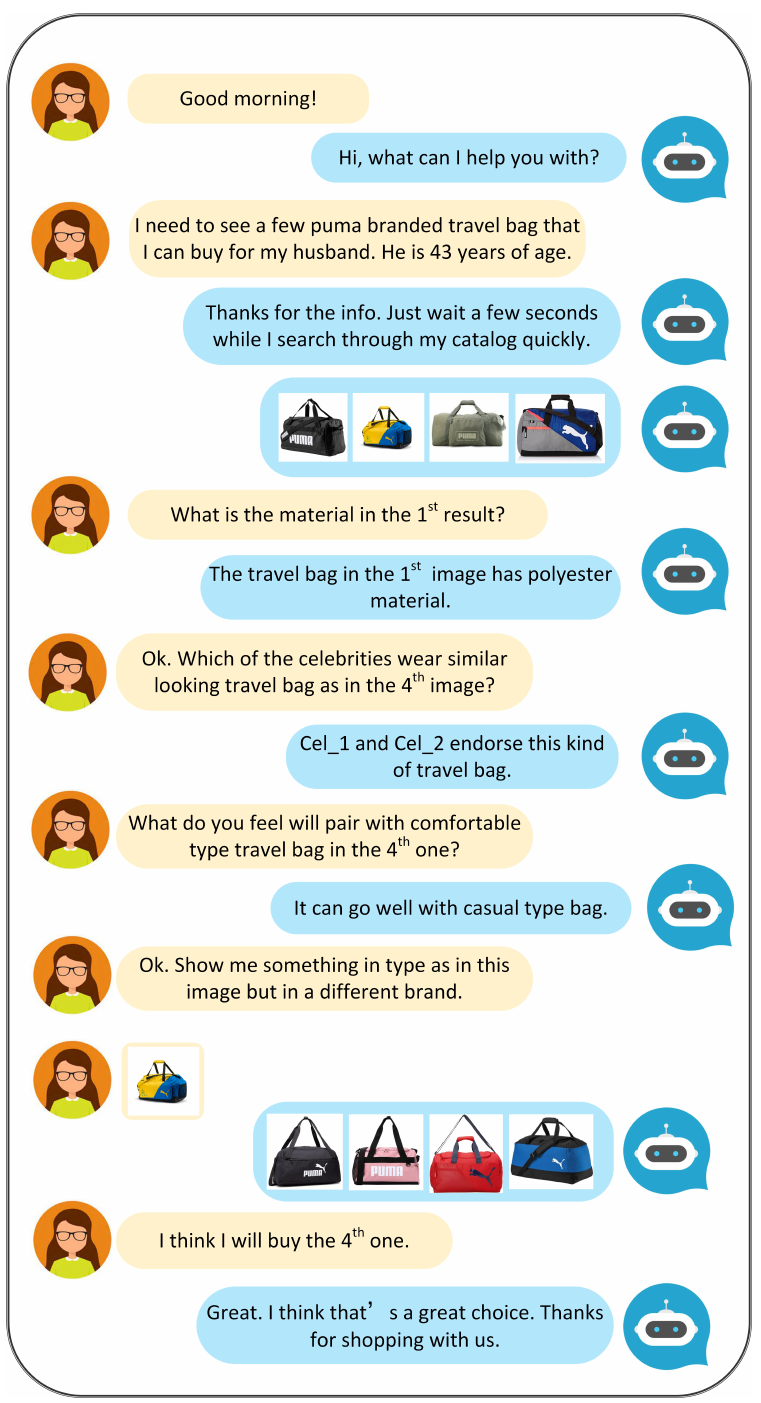
Figure 1. An example of a multimodal dialogue between a client and an